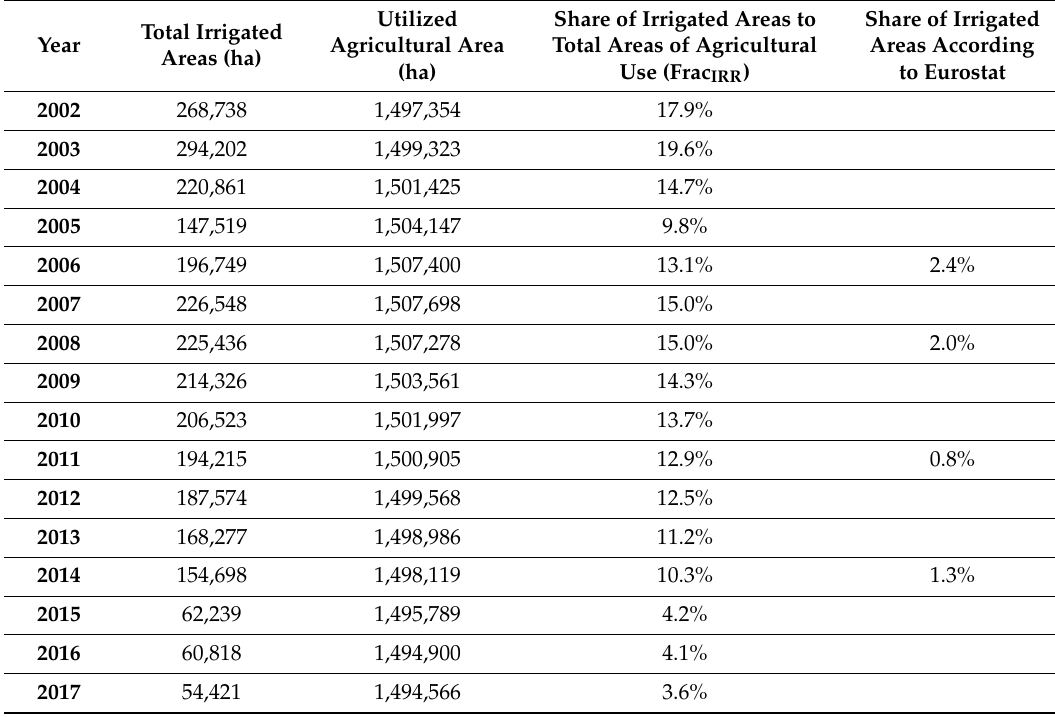
Table 1. Proportion of irrigated areas to total utilized agricultural areas.